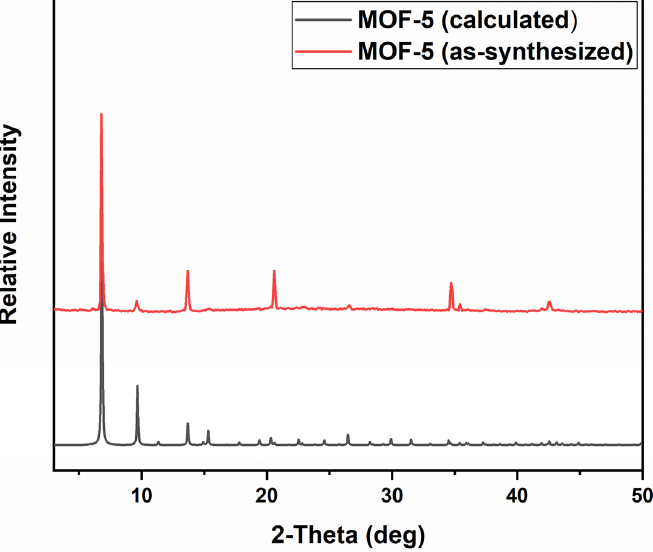
Figure 2. PXRD patterns of the as-synthesized (red) and simulated (black) MOF-5. The PXRD patterns of Ni-MOF-5 and Co-MOF-5 obtained from 0.5 M concentrations